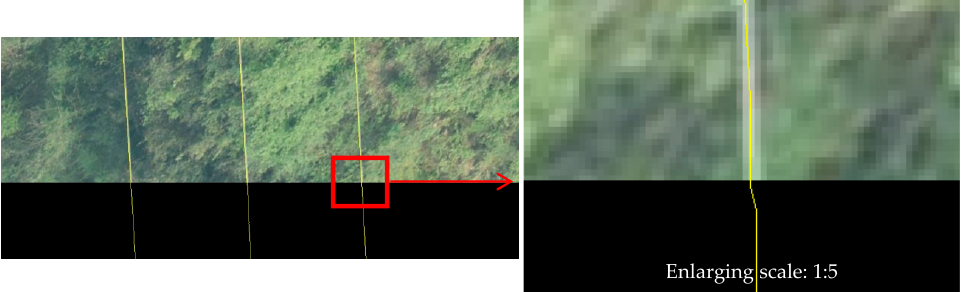
Figure 15. Registration of a 2D vector and epipolar images of the power line.